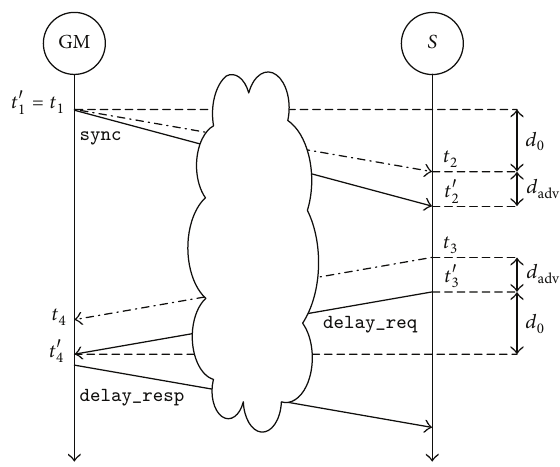
Figure 7: Clock synchronization protocol under